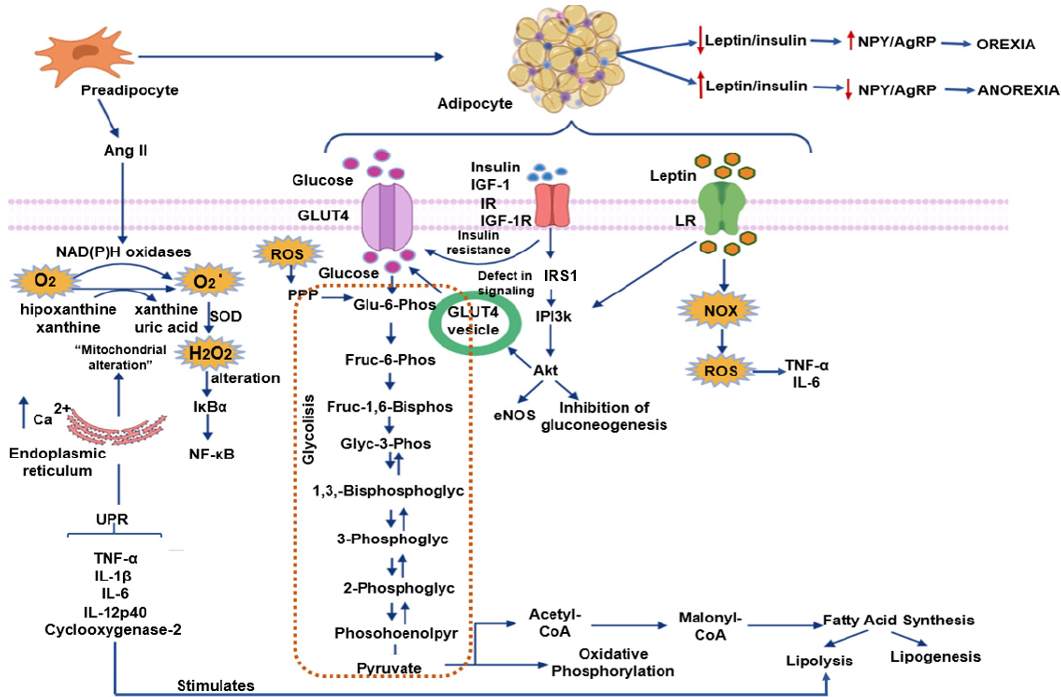
Figure 1. Pathways generating reactive oxygen species (ROS) and their impact on obesity Abbreviations: AgRP = agouti-related protein, Ang II = Angiotensin II, eNOS = endothelial nitric oxide synthase, H 2 O 2 = hydrogen peroxide, I κ B α = nuclear factor of kappa light polypeptide gene enhancer in B-cells inhibitor, GLUT 4 = gucose transporter type 4, IGF-1 = insulin-like growth factor 1, IGF-1R = insulin-like growth factor 1 receptor, IL = Interleucine, IR = insulin receptor, IRS 1 = insulin receptor substrate 1, LR = Leptin receptor, NF- κ B = nuclear factor κ -light-chain-enhancer of activated B cells, NOX = nicotinamide adenine dinucleotide phosphate oxidase, NPY = neuropeptide Y, O 2 − = superoxide anion, PI3k = phosphoinositide 3-kinase, PPP = pentose phosphate pathway, ROS = reactive oxygen species, SOD = superoxide dismutase, TNF- α = factor de necrosis tumoral alfa, UPR = unfolded protein response. Blue arrows indicate flow through the pathway; red arrows indicate increases or